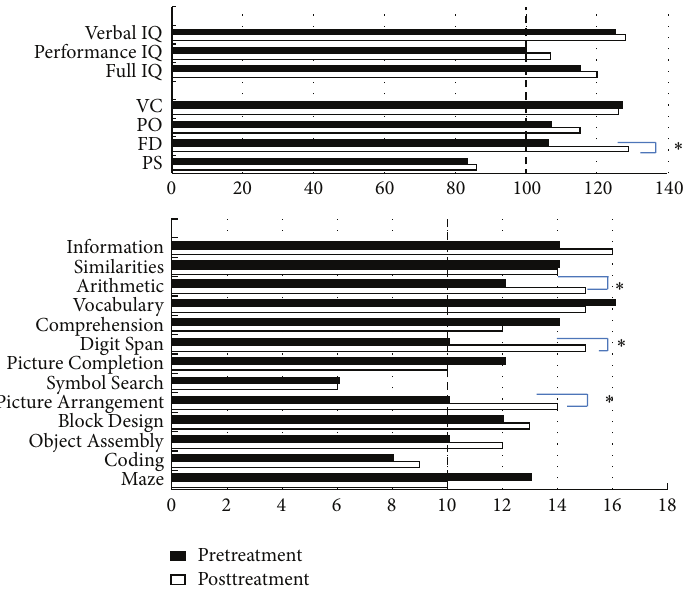
Figure1:WechslerIntelligenceScaleforChildren-ThirdEdition(WISC-III)scoresofIQ,4factorsand13subscoresbeforeandaftertreatment. Verbal IQ is calculated by the scores of “Information,” “Similarities,” “Arithmetic,” “Vocabulary,” and “Comprehension.” Performance IQ is calculated by the scores of “Picture,” “Comprehension,” “Coding,” “Picture,” “Arrangement,” “Block Design,” and “Object Assembly.” Full IQ = Verbal IQ + Performance IQ. VC (verbal comprehension) is calculated by the scores of “Information,” “Similarities,” “Vocabulary,” and “Comprehension.” PO (perceptual organization) is calculated by the scores of “Picture Comprehension,” “Picture Arrangement,” “Block Design,” and “Object Assembly.” FD (freedom of distraction) is calculated by the scores of “Arithmetic” and “Digit Span.” PS (performance speed) is calculated by the scores of “Coding” and “Symbol Search”. ∗ 𝑃 < 0.05 .